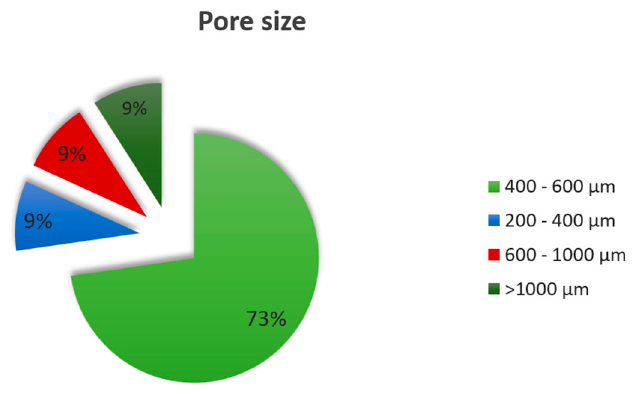
Figure 6. Synthesis of pore size positive influence on bone ingrowth results.